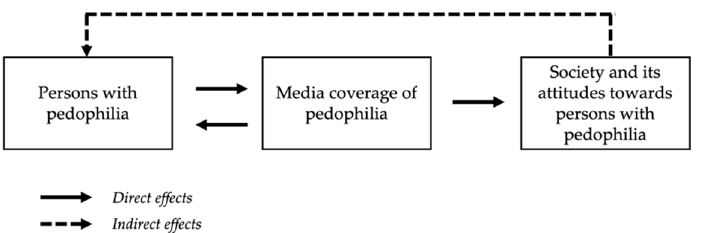
Figure 1. Reciprocal media effects on individuals with pedophilia as well as society (modified version of the model of reciprocal media effects [67,68]).